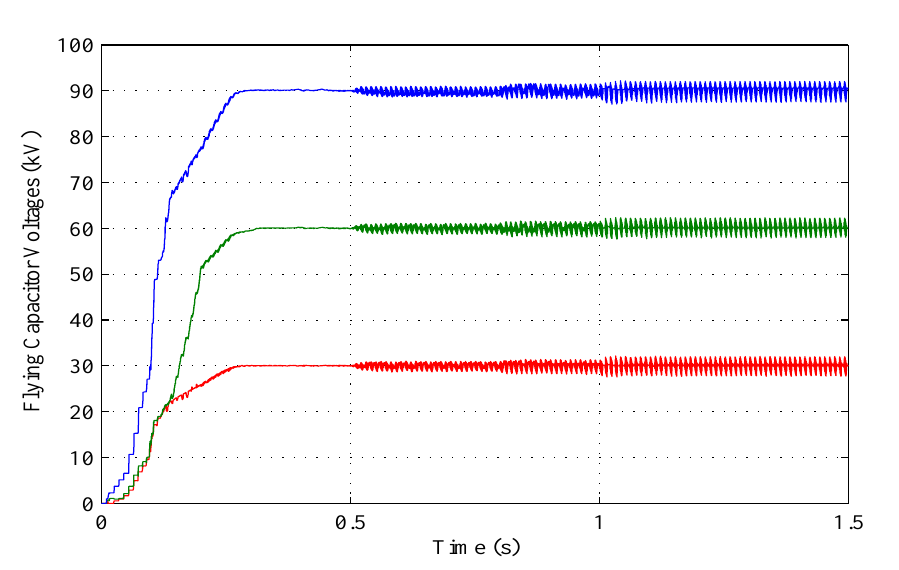
Figure 15. Voltages of the flying capacitors (leg A of the voltage-source converter (VSC)) in kV: V (blue), V (green) and V (red). C 1 C 2 C 3